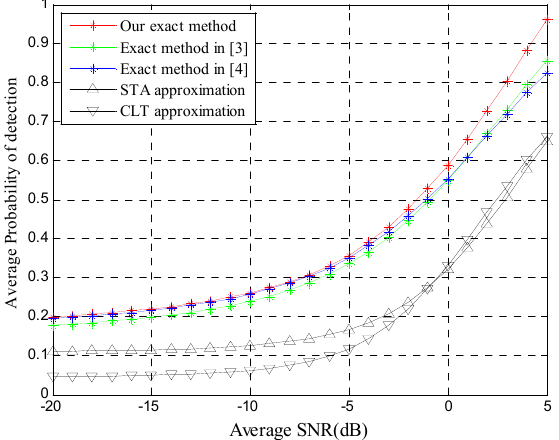
Figure 2. Average detection probability vs. signal-to-noise ratio (SNR) for P f = 0.01, α = 2, µ =